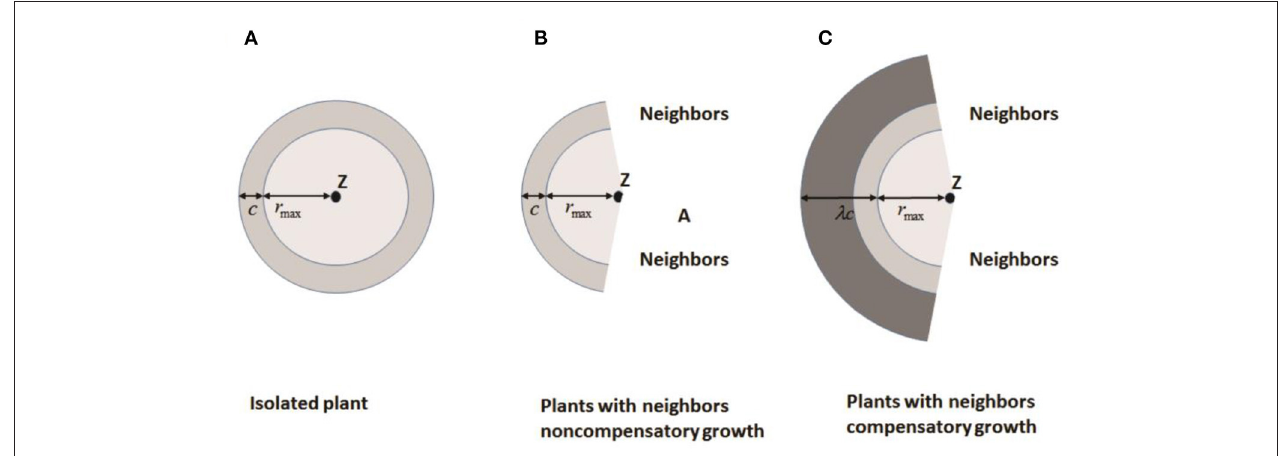
FIGURE 3 | Increase in area of influence for: (A) an isolated plant; (B) a plant with no compensatory growth in the presence of neighbors, and (C) a plant with compensatory growth in the presence of neighbors. Z is the plant center, c is the radial increase of a circular plant in the absence of neighbors, r max is the distance between a plant center and its most distant edge, and λ is a compensatory parameter (Redrawn from Brisson and Reynolds,